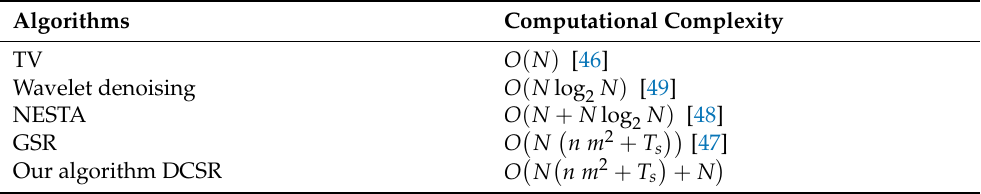
Table 2. Computational